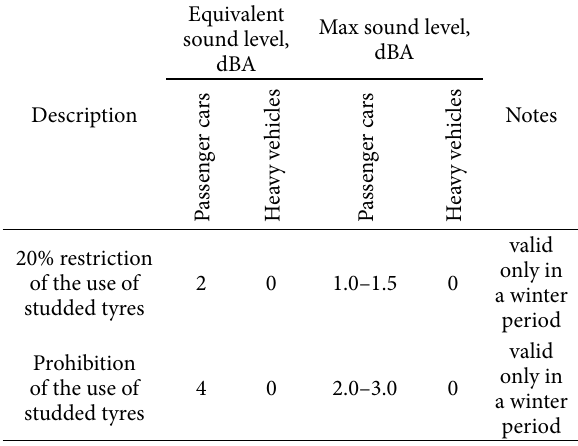
Table 2. Change in the equivalent and max sound levels having reduced or prohibited the use of studded tyres by Kropp et al.